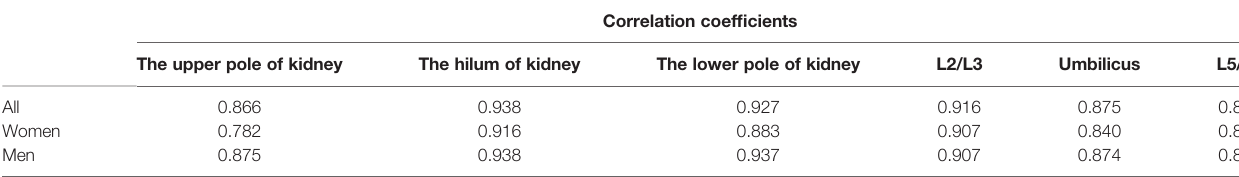
TABLE 5 | The Pearson ’ s correlation of measurement between a single slice with the total fat volume.